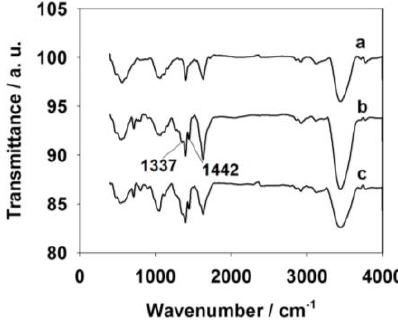
Figure 2. FT-IR spectrometry: ( a ) CNTs; ( b ) CNTs-PBA; ( c ) CNTs-PBA/GAs.